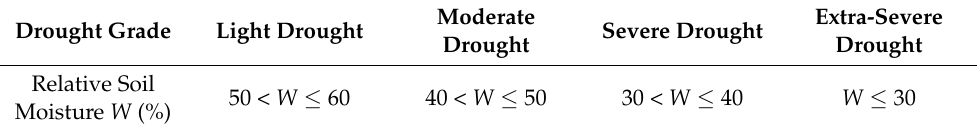
Table 1. Classification of relative soil